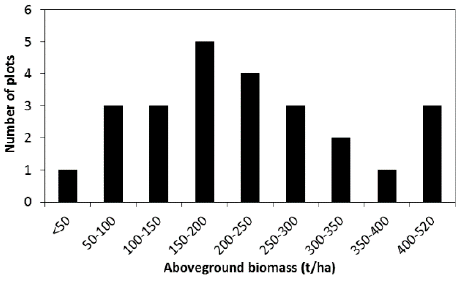
Figure 2. Histogram distribution of the measured 25 training plots for forest aboveground biomass (AGB) estimation.